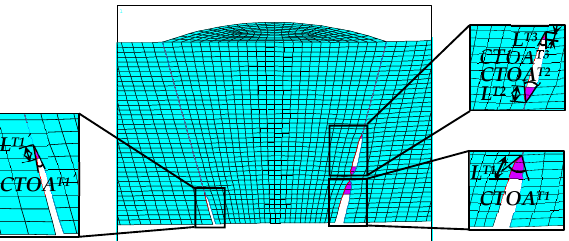
Figure 2. Crack propagation model under 18.8186 MPa load step.